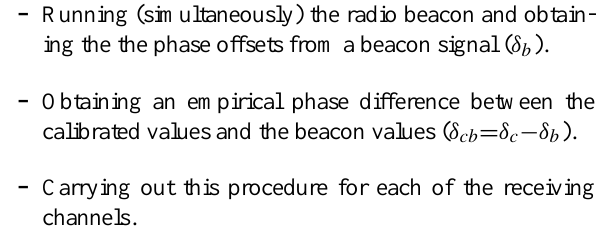
Fig. 6. Modified range-time intensity plot using Doppler information (RTDI). The lightness, hue, and saturation of the image pixels reflects the SNR, Doppler shift, and spectral width of the corresponding echoes. The legend on the left represents the SNR vs. Doppler color map for a saturation value of 100%. The legend on the right represents the spectral width vs. Doppler color map for a 50% of